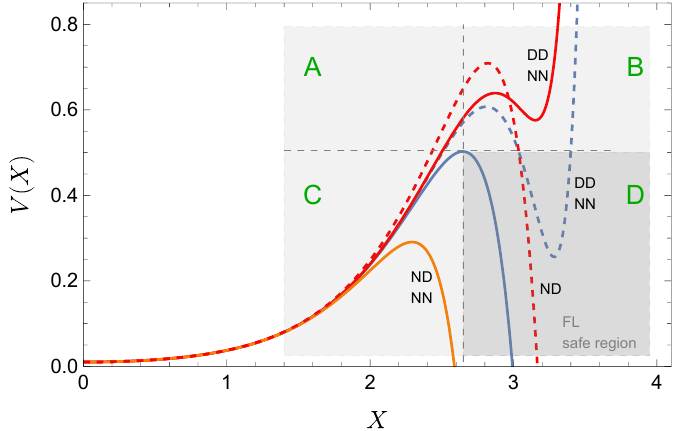
Figure 5 . The location of extrema of the radion potential for various choice of scalar sector parameters, as compared to the no scalar case (solid blue). The extrema can move in four possible directions (denoted by the four regions A, B, C, D ), and the darker gray region D is safe if the original extremum satisfied the FL condition. Requiring FL condition on the extrema in the other regions leads to constraints on the scalar sector. Also indicated are the boundary conditions that generically give rise to the typical